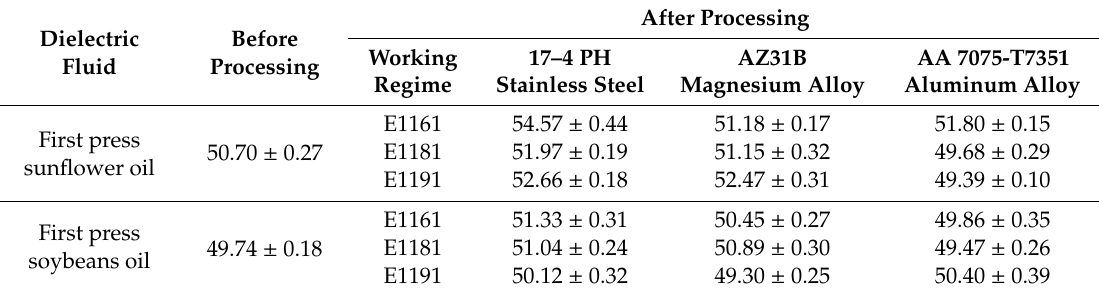
Table 10. Dynamic viscosity of the vegetable oils, η